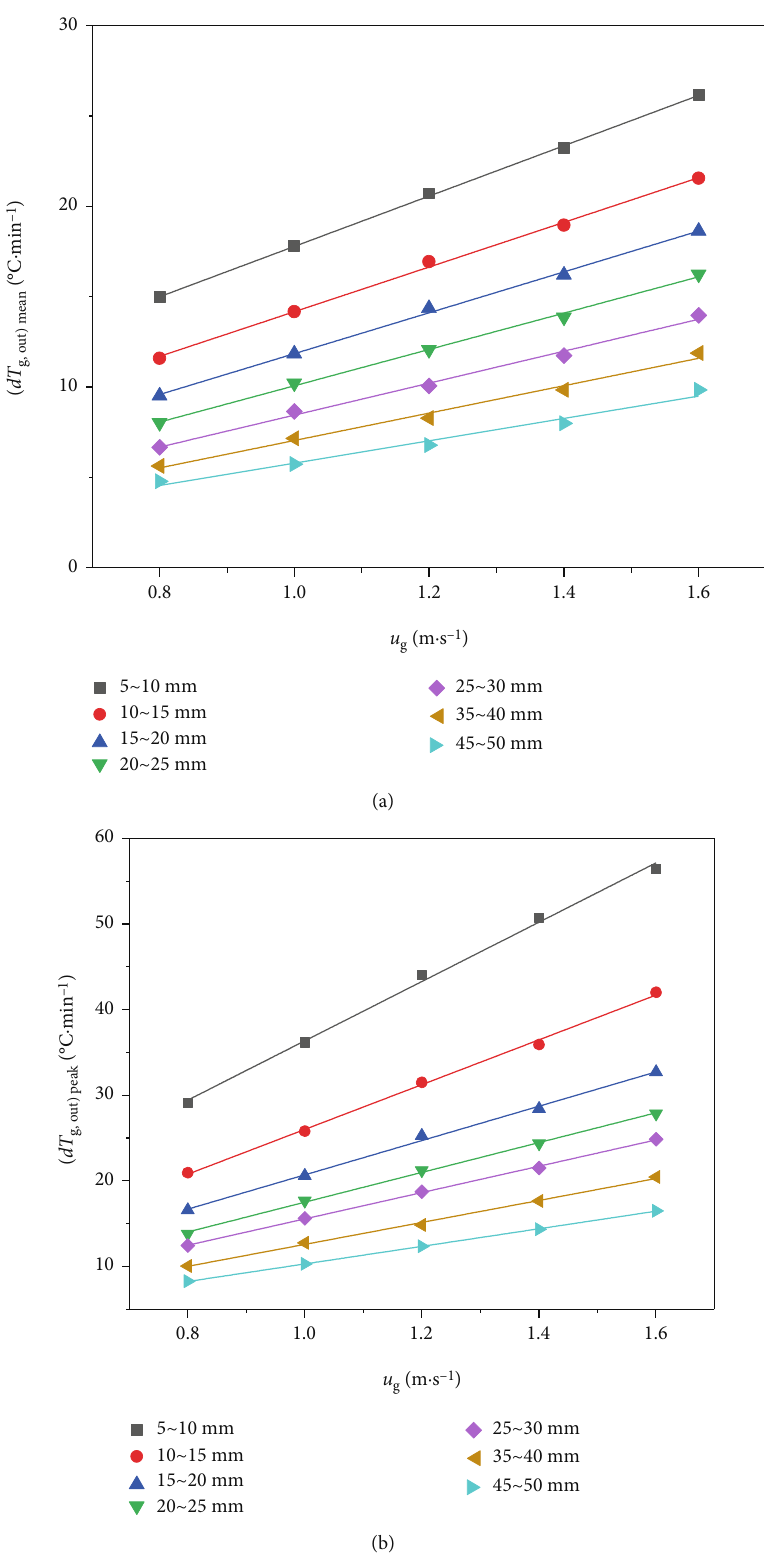
Þ and peak value ð dT g,out mean